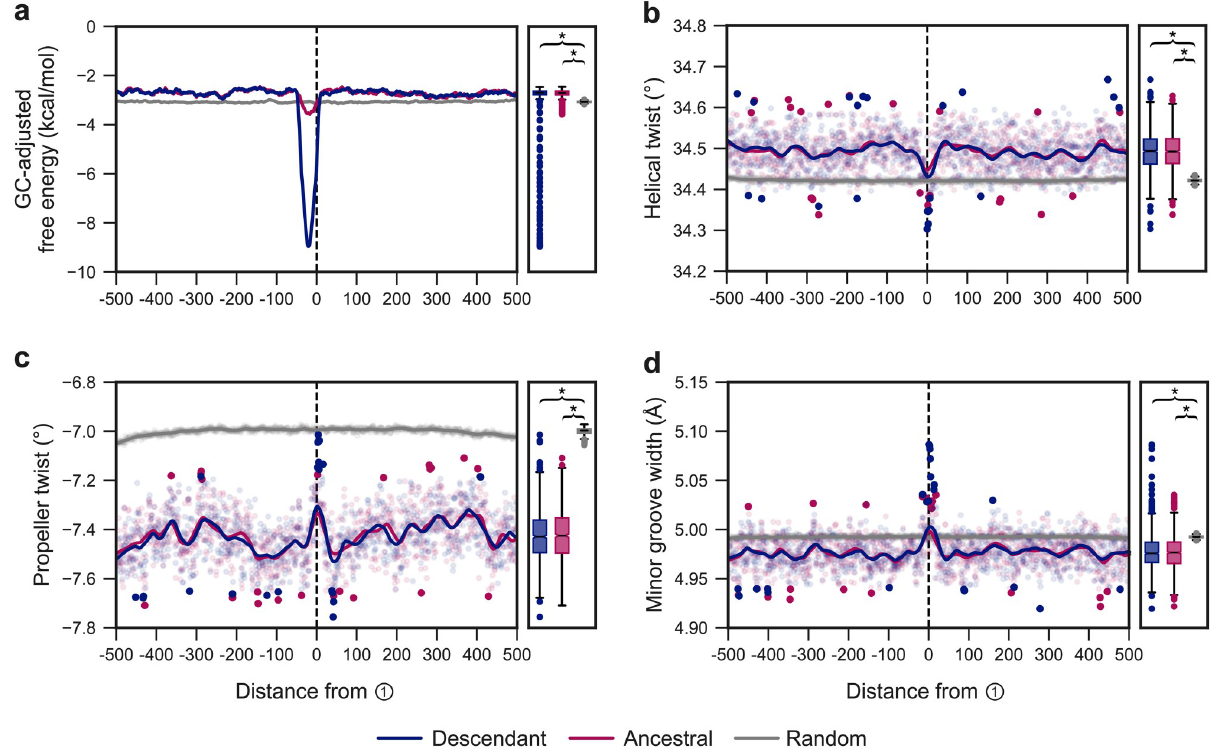
Fig 7. Single-nucleotide resolution signals of DNA secondary structure stability and bendability for the gold-standard event set. (A) Mean GC content-adjusted free energies of the MFE secondary structures for the ancestral and descendant sequences, compared to a random genomic background ± 500nt around switch point ① using a left-aligned sliding window size of 50 in single nucleotide steps (e.g. at position -500, the MFE structure is calculated using the sequence from position -500 to -451). Marginal box plots summarise the distributions of mean values within the ± 500nt region, and brackets indicate significantly different MFEs ( p < 2 × 10 − 16 ) between groups under a Wilcoxon rank-sum test. (B, C, D) Mean predicted helical twist, propeller twist and minor groove width ± 500nt around switch point ① . Points represent mean feature values as calculated using DNAShapeR [37], utilising a pentamer sliding window centred on each position, and a Loess fitted curve is overlaid. Additionally, the smallest and greatest 1% of mean values are shown as solid points to highlight extreme values. Box plots as in (A).